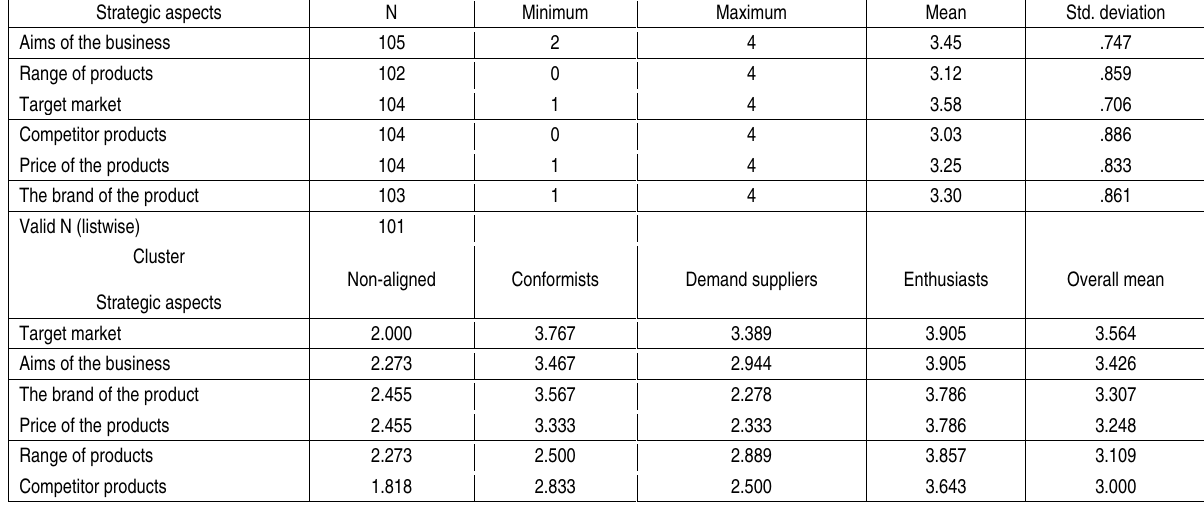
Table 3. Mean level importance levels of strategic product aspects and